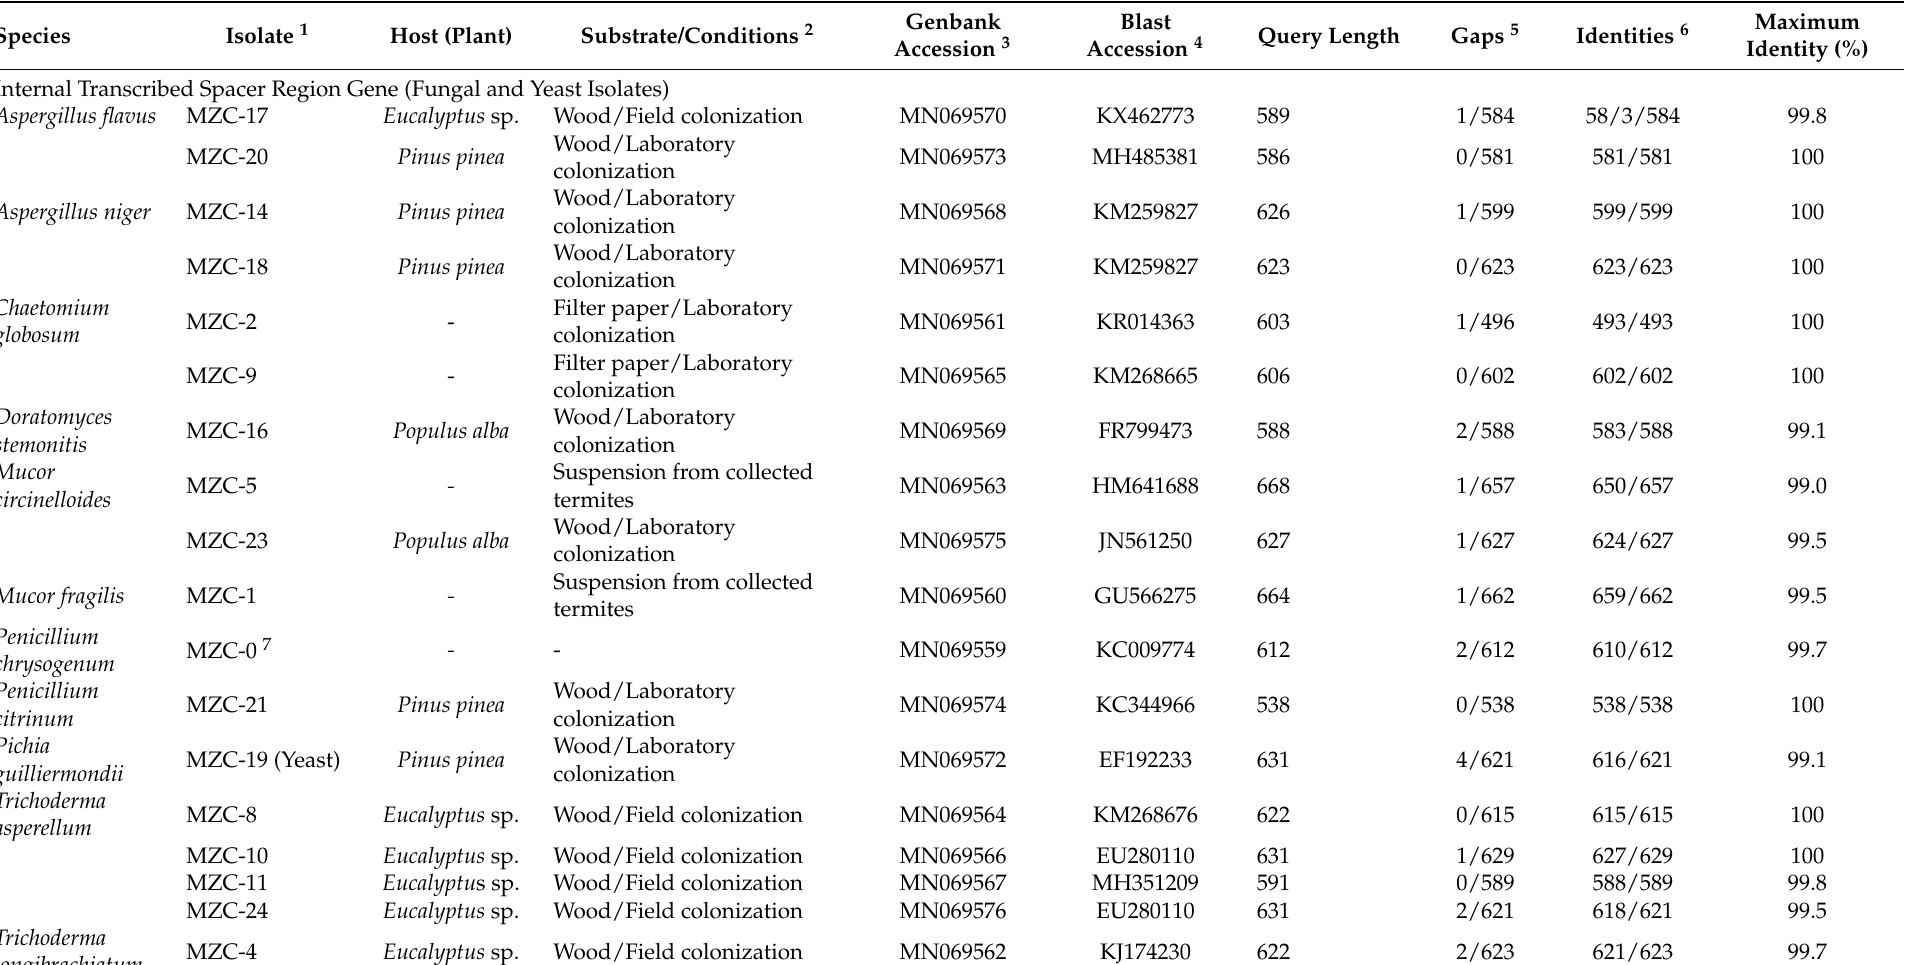
Table 2. List of microorganisms associated with the activity of the subterranean termite Reticulitermes grassei , with their corresponding GenBank accession numbers and data of Blast results obtained from